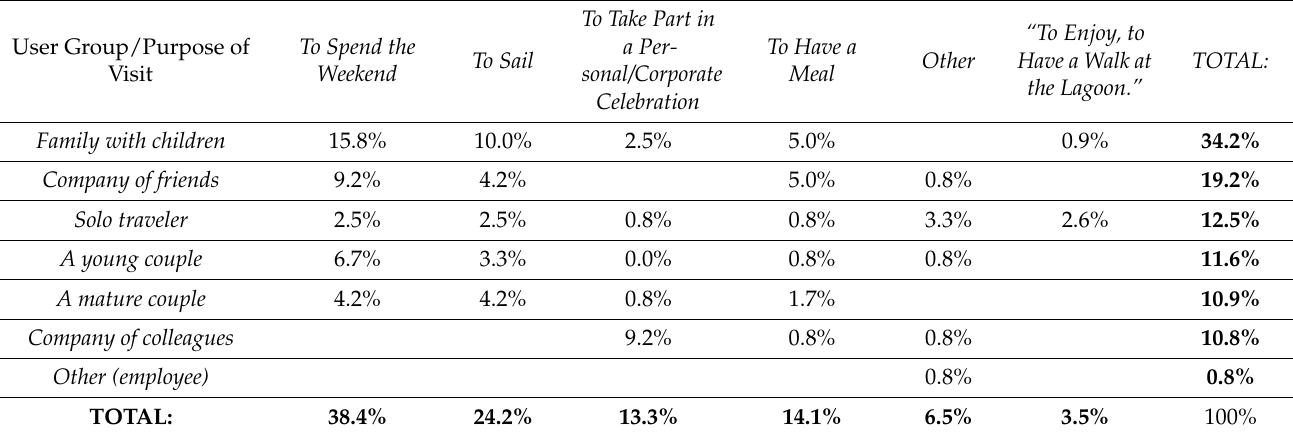
Table 3. Visitor distribution by category and the purpose of visiting marinas.